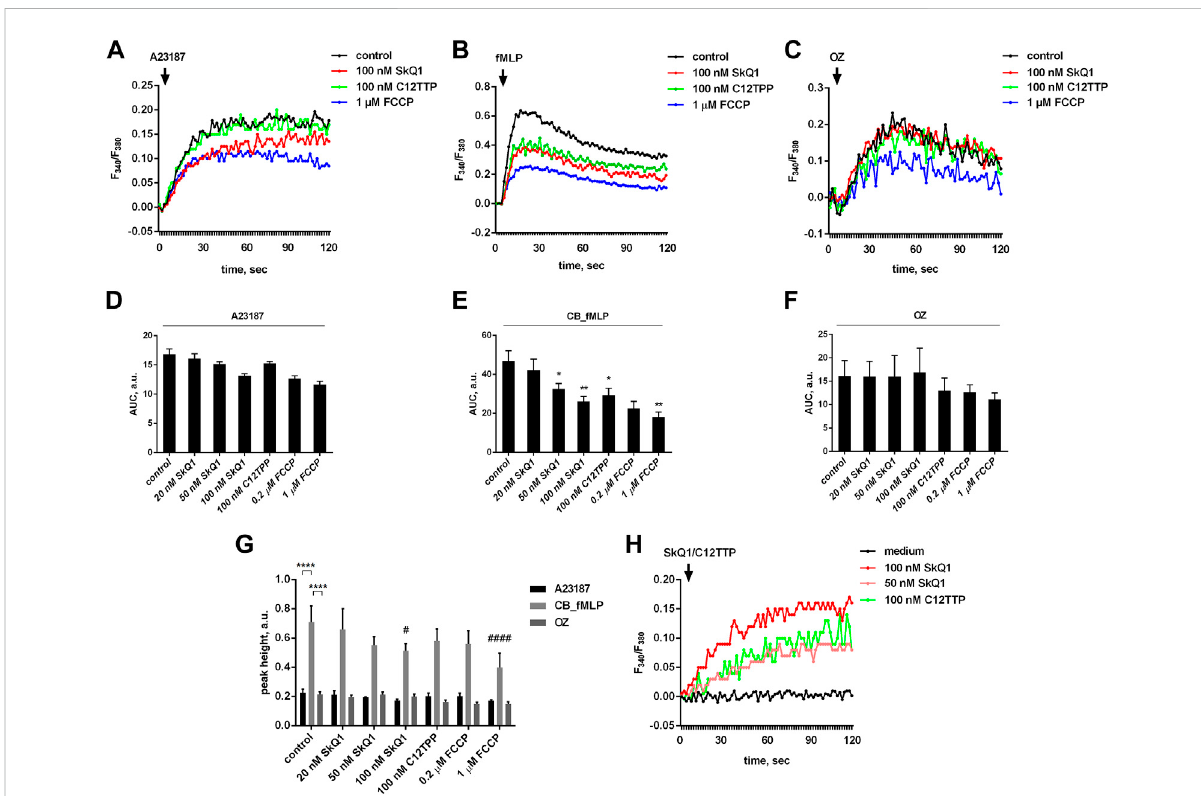
FIGURE 2 Effect of SkQ1, C12TTP and FCCP on cytosolic calcium levels in human neutrophils. PMNLs loaded with fura-2 dye (4 × 10 5 per sample) were pre-incubated for 10 min in HBSS/HEPES medium, treated with indicated doses of SkQ1, C12TTP or FCCP for 30 min and stimulated with 1 μ M A23187, sequential addition of 5 µM cytochalasin B (10 min) and 0.1 µM fMLP or OZ (0.04 mg/ml). Fluorescence intensity at 510 nm of Ca 2+ -bound andCa 2+ -freeFura-2wasmeasuredeverysecondfor120 saftertheadditionofstimuli (A – G) orimmediatelyaftertheadditionSkQ/C12TTP(h). Changes in [Ca 2+ ] c are presented as typical blank corrected curves of fura-2 fl uorescence ratio 335/380 (A – C,H) . Areas under curves within the measurement interval in arbitrary units (AUC, a. u.) are presented on (D – F) as means ± SEM ( n = 4; * p < 0.05, ** p < 0.01 compared to control values; by one-way ANOVA followed by Dunnett ’ s multiple comparisons test). Differences between the maximum and minimum values of F 340 /F 380 (peak heights, a. u.) were assessed within the measurement interval and presented on (g) as means ± SEM ( n = 4; # p < 0.05, #### p < 0.0001, compared to corresponding control values; **** p < 0.0001 for pairs of data indicated by brackets; by two-way ANOVA followed by Tukey ’ s multiple comparison